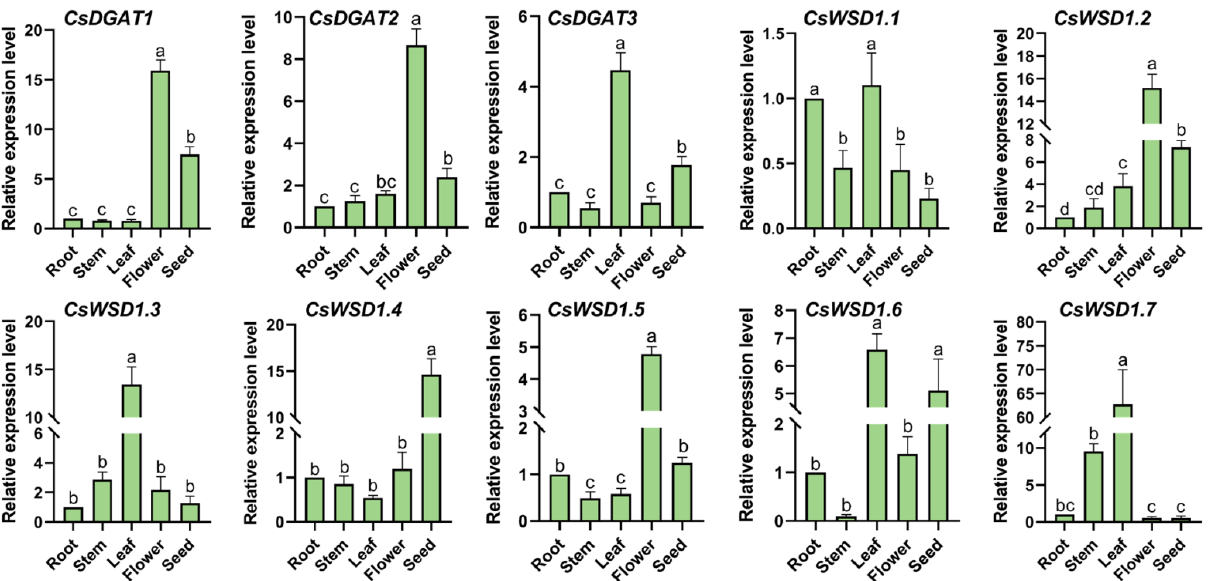
Figure 7. Expression patterns of the CsDGAT genes in different tissues detected by RT-qPCR. The characters on the X -axis show the different tissues of C. sativa (root, stem, leaf, flower, and seed). The Y -axis indicates the relative expression level of different genes. Three replicates were performed, and the vertical bar is the standard error. The actin7 gene was used as an internal reference. Significant differences between the different group are indicated by different letters a – d ( p < 0.05).